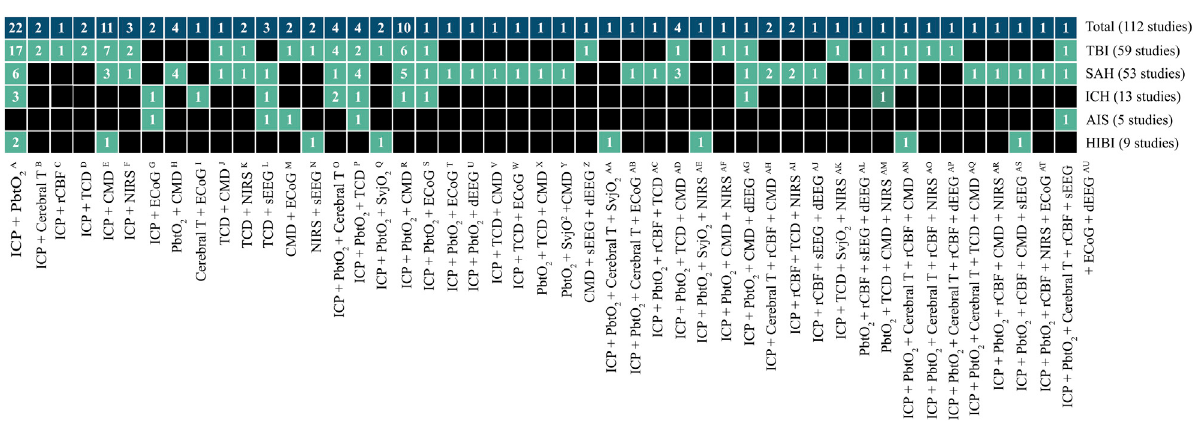
FIGURE 3 Unique cerebral multimodality monitoring combinations. The 47 unique combinations of MMM are shown. The fi rst upper row shows the total number of studies per combination. The second to the sixth row shows the number of studies per acute brain injury: TBI, SAH, ICH, AIS, and HIBI. Eachboxdescribesthenumberofstudies.Theboxesinblackdonotincludeamonitoringcombinationforaparticulardisease.Thereferencesofthe studies are added to Supplementary Tables S5A – D. The reference numbers per unique combination are: A (11,14,24,33,43,46,47,48,49,53, 69,71,87,90,91,94,97, 104,105,106,107,110); B (51,55); C (4); D (76,31); E (9,38,45,61,62,63,66,67,77,82,101); F (32,37,73); G (8,60); H (17,70,95,98); I (21);J(78);K(6,74);L(23,57,58);M(10,20);N(68,79);O(30,40,42,100); p (83,86,93,96);Q(35,44);R(1,3,13,19,34,52,56,59,89,102);S(2);T(27);U(29); V (112); W (64); X (99); Y (5); Z (15); AA (111); AB (16); AC (103); AD (80,92,108,109); AE (81); AF (41); AG (50); AH (12,39); AI (75,88); AJ (18); AK (84); AL (22);AM(72);AN(36);AO(7);AP (26);AQ(85);AR(54);AS(28);AT(65);AU(25).Note:thesumofstudiesfortheindividualdiseasesnotcount towards thetotalnumberofstudiesbecauseastudycanincludepatientswithdifferentdiseases.AIS,acuteischemicstroke;CerebralT,cerebraltemperature; CMD, cerebral microdialysis; dEEG, depth electroencephalography; ECoG, electrocorticography; HIBI, hypoxic-ischemic brain injury following cardiac arrest; ICH, intracerebral hemorrhage; ICP, intracranial pressure; NIRS, near-infrared spectroscopy; PbtO 2 , partial pressure of brain tissue oxygenation; rCBF, regional cerebral blood fl ow; SAH, subarachnoid hemorrhage; sEEG, surface electroencephalography; SvjO 2 , jugular bulb venous oximetry; TBI, traumatic brain injury; TCD, transcranial